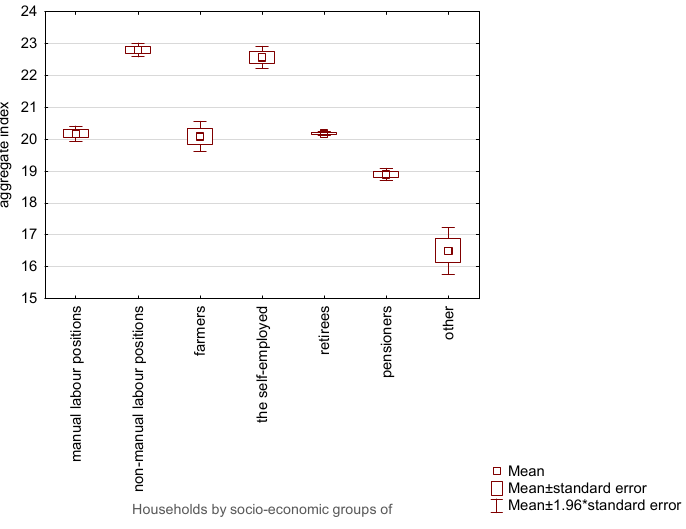
Figure 10. The level of the aggregate indicator in 2018 according to the socioeconomic group of households of people aged 60 and older. Source: own elaboration based on data from [136].